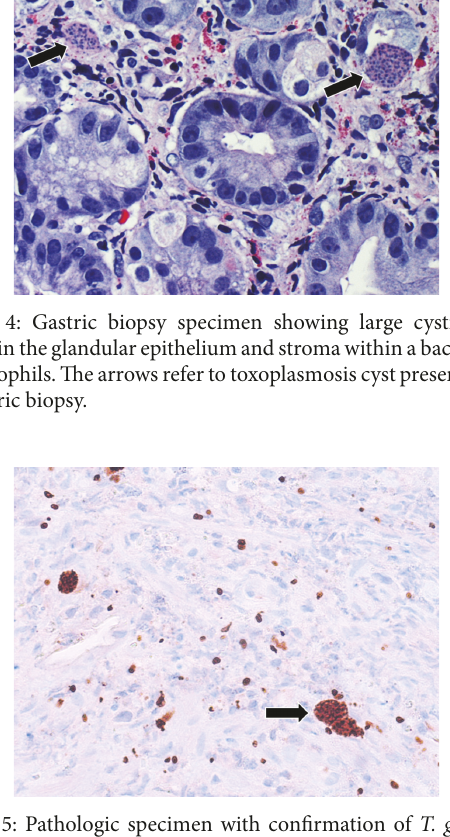
Figure2:Colonoscopywithulcerationsinthececumandascending colon.